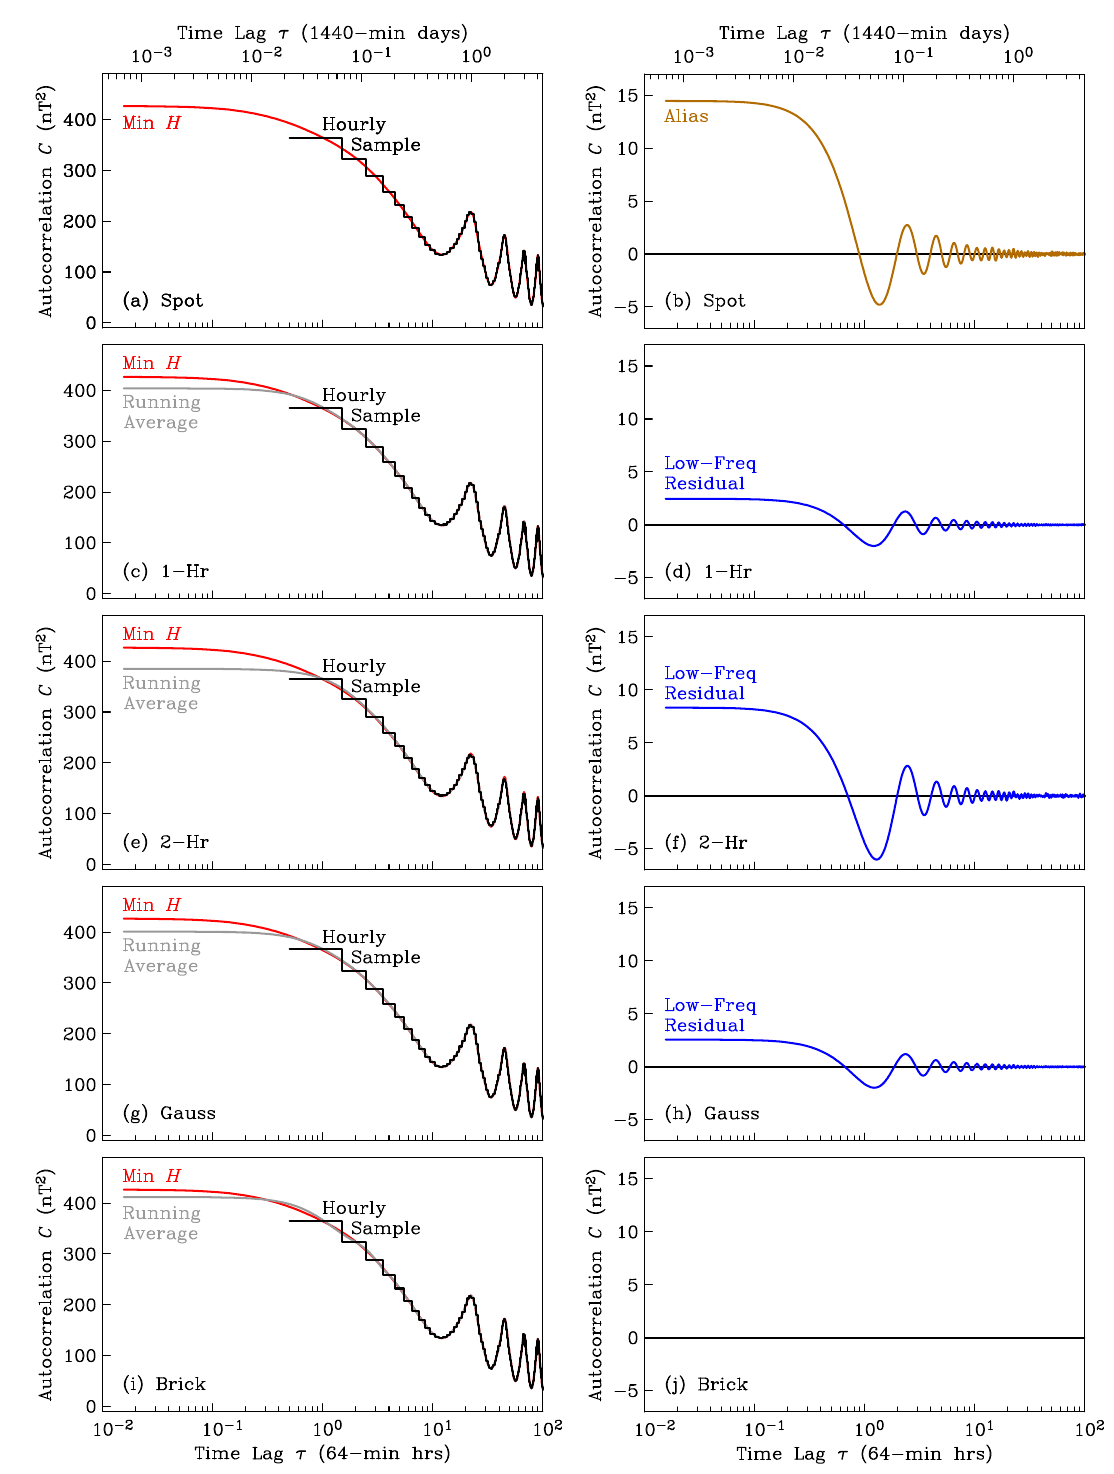
Fig. 5. Autocorrelation C H (τ) as a function of time lag τ , for CLF- H 1991.0–2009.0: (a, b) spot (c, d) 1-h, (e, f) 2-h, (g, h) Gaussian, and (i, j) brick-wall average-samples. Shown are autocorrelation of the source 1-min data C H (τ) (red), running averages C H a (τ) (gray), discrete hourly average-samples C H as (τ j ) (black), low-frequency residuals C L a (τ) (blue), and aliasing C S s (τ) (brown).